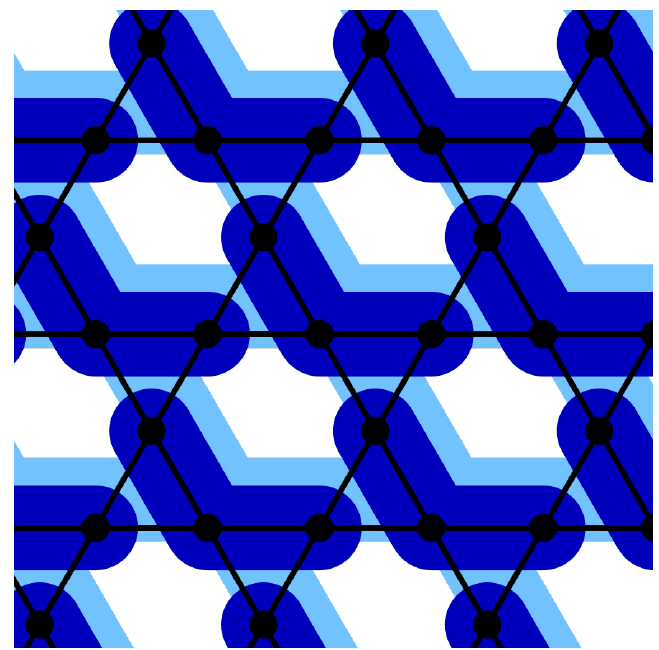
Figure 4: The mapping of the kagome lattice to the square lattice used here. Three sites of the kagome lattice (black circles) are merged into one site of the square lattice (dark blue). Each link between two square-lattice sites (light blue) corresponds to two links of the kagome lattice (black lines).